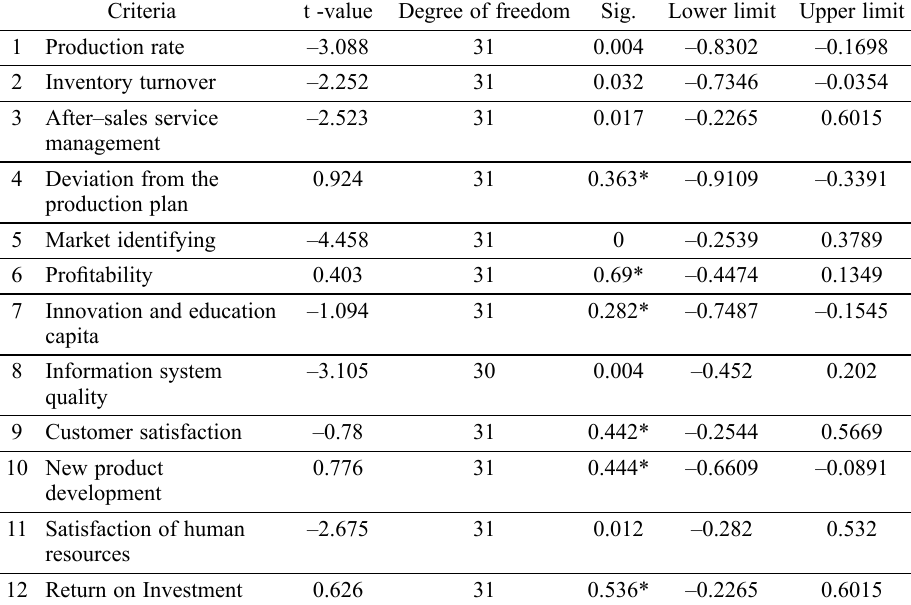
Table 3. Results of T–test for selection of criteria related to disruption strategies’ evaluation